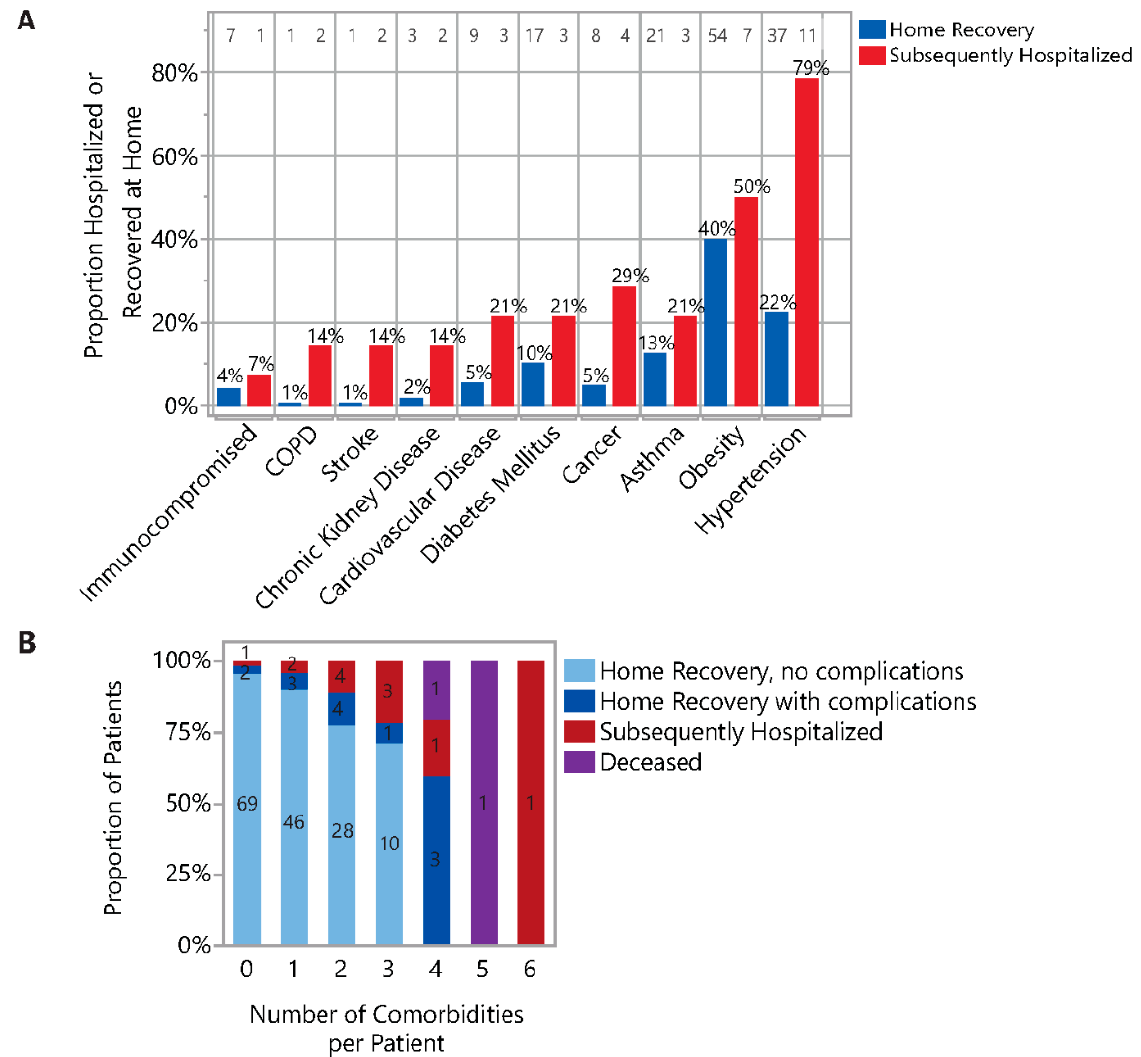
Figure 4. Comorbidities are of high prognostic value. ( A ) Proportion of patients with individual comorbidities in the Home Recovery and the Subsequently Hospitalized groups. Number of patients with indicated comorbidity are annotated along the top of the figure and top of bars are annotated with proportion of Home Recovery or Subsequently Hospitalized group. BMI was unknown for 31 Home Recovery patients. ( B ) Increasing numbers of risk factors corresponded with increasing risk of adverse outcome. Probability of home recovery declined steadily with increasing comorbidities.